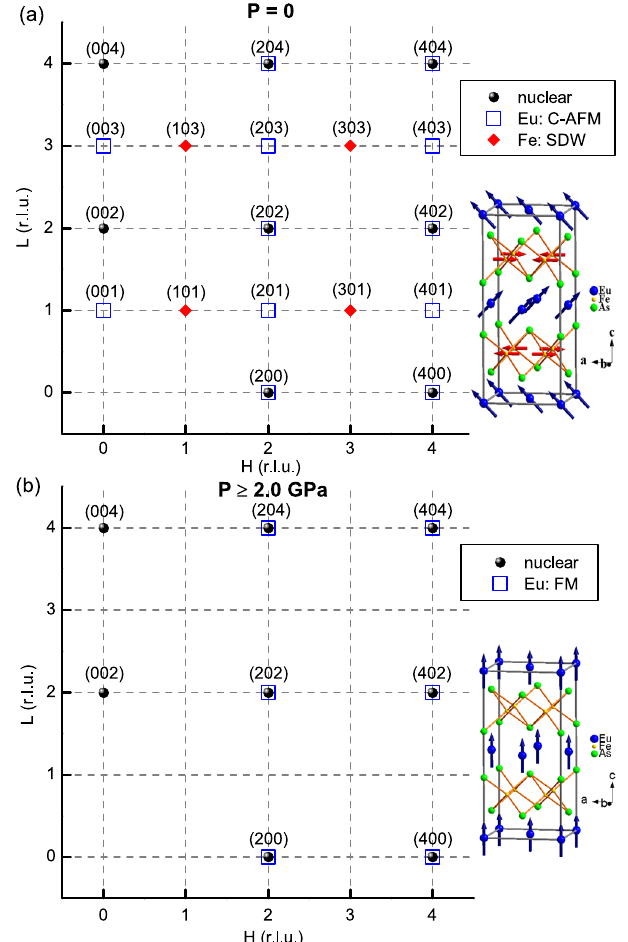
Figure 3. The magnetic structures of Eu(Fe 0.925 Co 0.075 ) 2 As 2 at the base temperature for P = 0 ( a ) and P ≥ 2.0 GPa ( b ), respectively. The expected nuclear peaks (black spheres) and magnetic reflections from Eu (blue squares) and Fe (red diamonds) in the (H 0 L) reciprocal plane are illustrated. At P = 0 ( a ), the Eu sublattice orders in the canted AFM structure and the Fe sublattice shows a SDW order. For P ≥ 2.0 GPa ( b ), the Eu sublattice shows a pure FM order and the antiferromagnetism in the Fe sublattice is completely